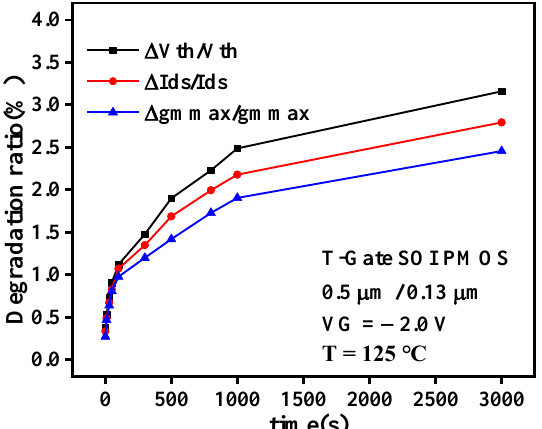
Figure 7. Degradation comparison of sensitive parameters after NBT stress.